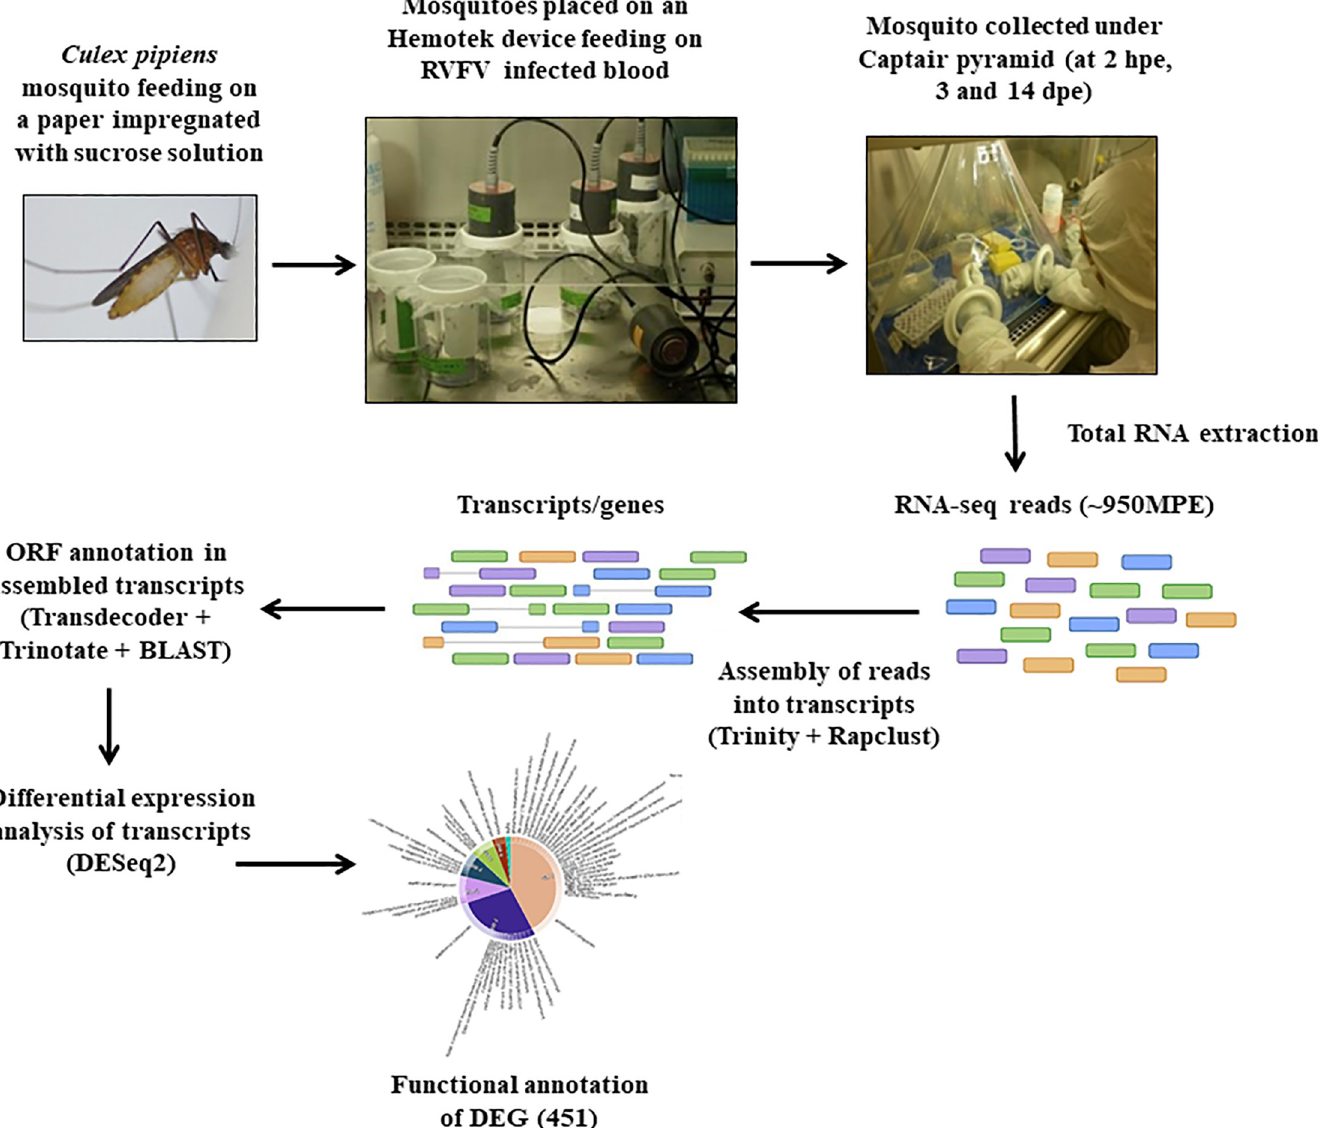
Fig 1. The workflow of the experimental infection in Cx . pipiens mosquitoes exposed to RVFV and transcriptome